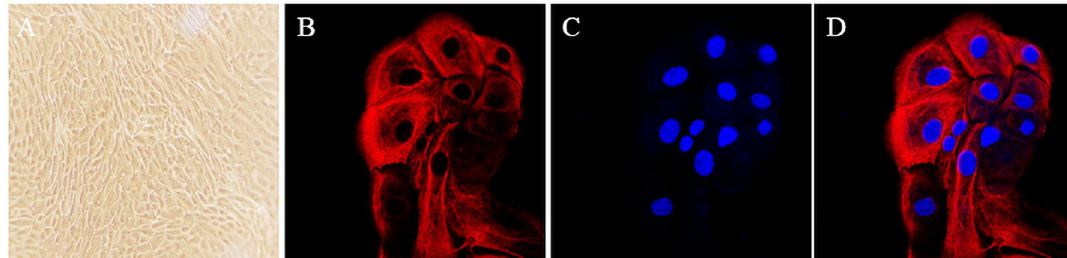
Figure 1. Culture and identification of bovine endometrial epithelial cells (bEECs). ( A ) Cell morphology under light microscope (× 100). ( B ) Expression of specific keratin 18 (red) in bEECs. ( C ) Blue is the nucleus stained by DAPI. ( D ) Combine (×